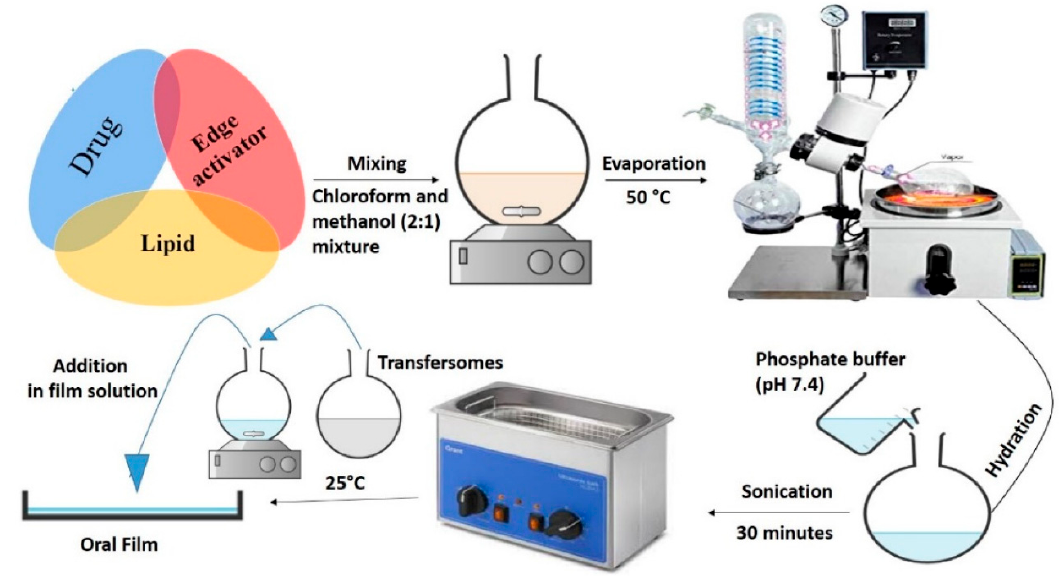
Figure 2. Schematic representation of the transfersomes formulation process [44]. Solid dispersions are also a common approach to increase drug dissolution.